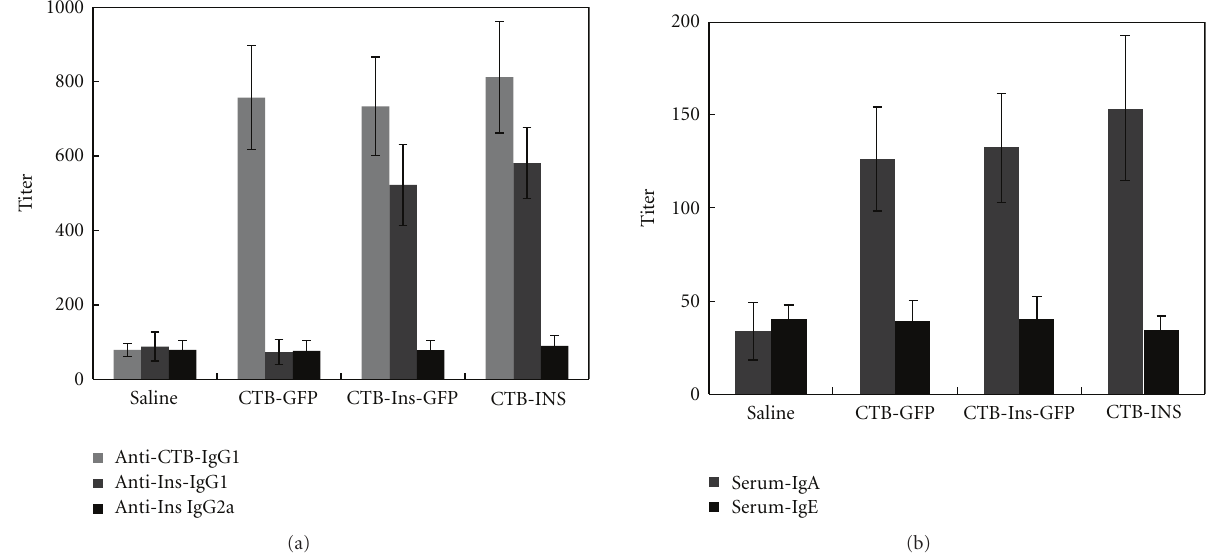
Figure 7: Serum antibody assay of treated NOD mice. (a) Anti-CTB IgG1, anti-insulin IgG1, and IgG2a serum antibody titers and (b) IgA and IgE serum titers in mice fed CTB-INS, CTB-Ins-GFP, CTB-GFP, or Saline. Results are presented as the mean titer values ± SD. Four or five mice per group were individually tested in two separate experiments.